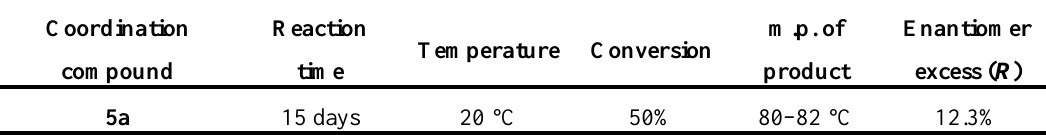
Table 2. Nitroaldol addition of nitromethane with 2-nitrobenzaldehyde catalysed by coordination compound 5a .